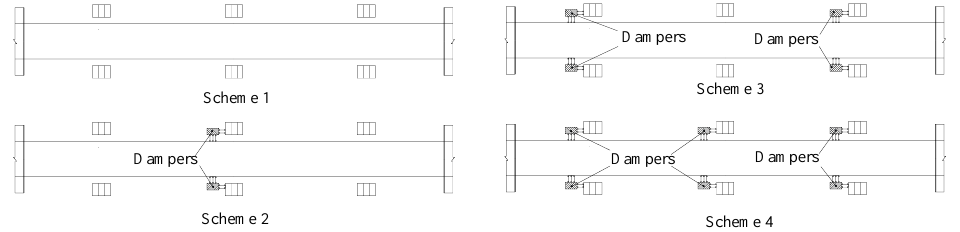
Figure 6. Three different damper layout schemes.